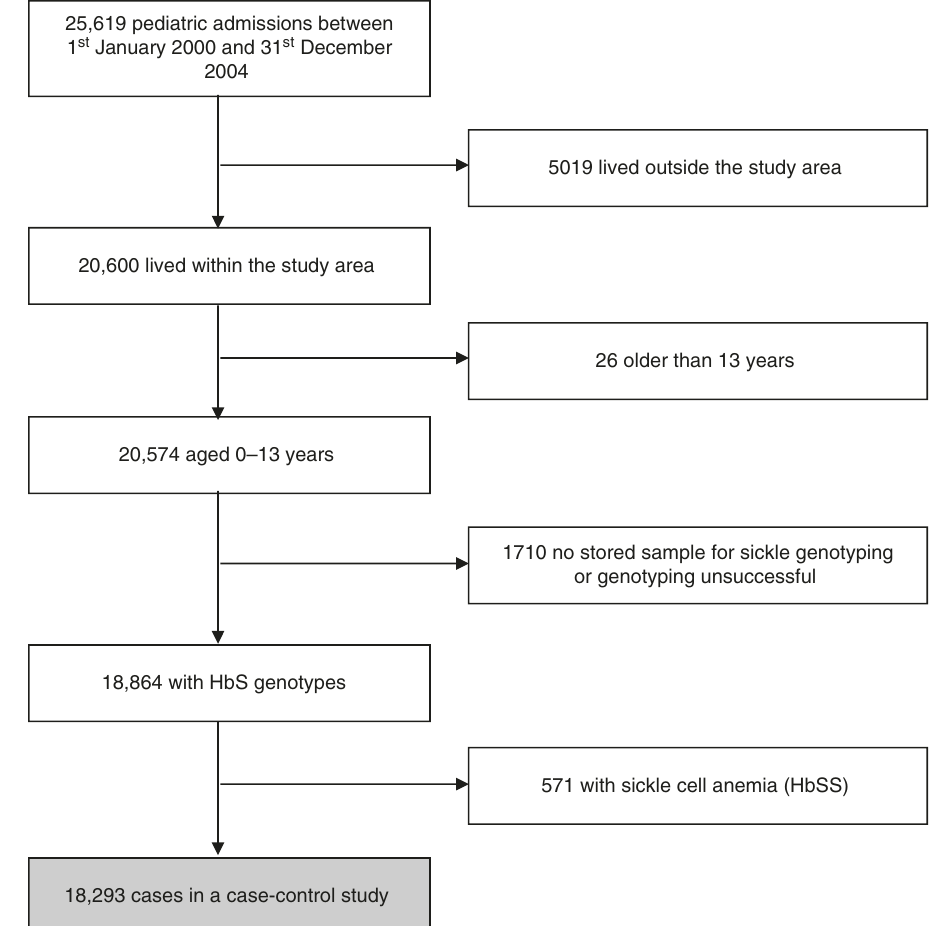
Fig. 1 Pro fi le showing the derivation of the case-patients included in the study. Figure shows the sample fl ow for patients contributing to the hospital admission data